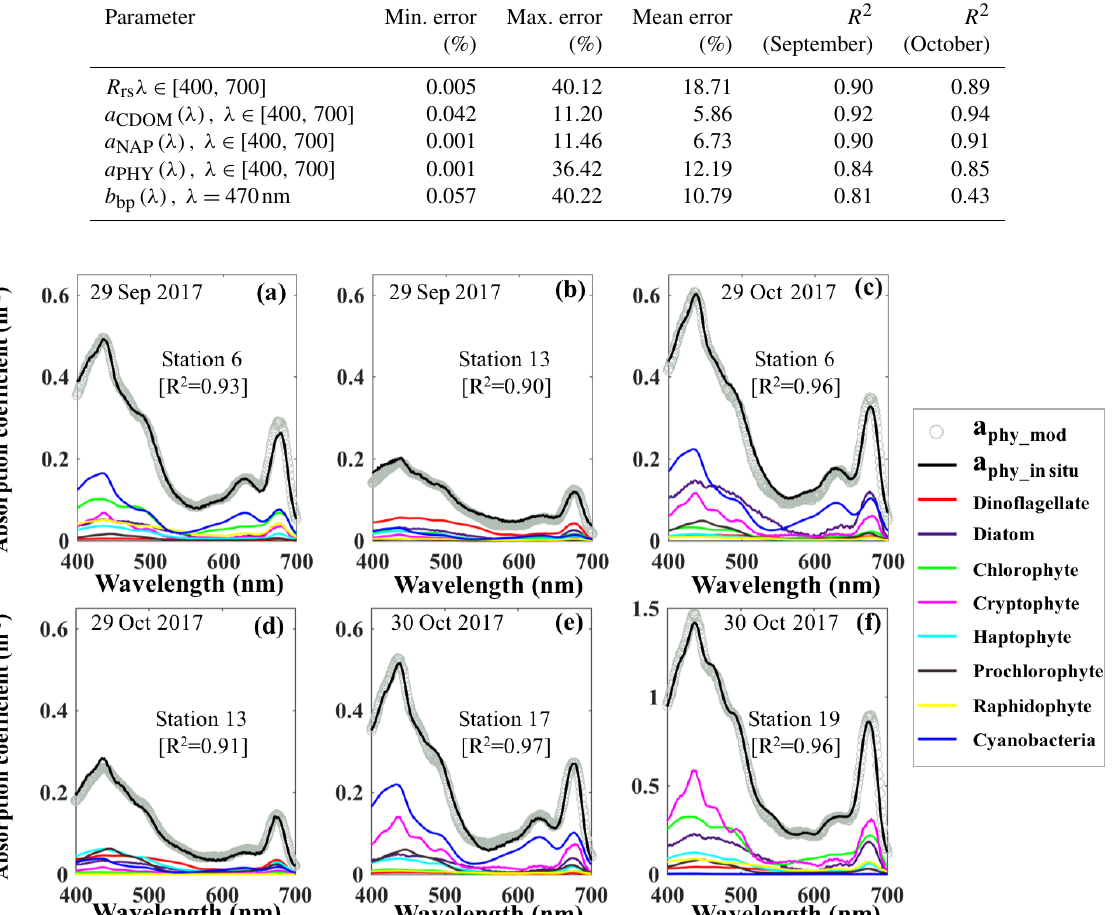
Table 3. Error statistics over all wavelengths and sampling stations ( N = 301 × 34 = 10234; 12 and 22 stations on 29 September and 29– 30 October 2017) from a semi-analytical IOP inversion algorithm.